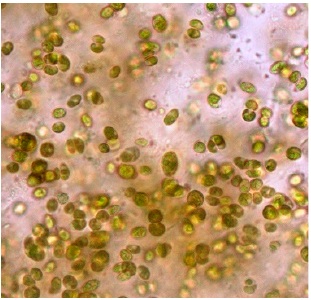
Figure 7. Microalgae immobilized on alginate beads before ( a ) and after ( b ) the experiment. The natural polysaccharide was a good carrier medium for microalgae. Microscopic images confirmed a higher density of cells immobilized on alginate beads (Figure 8).